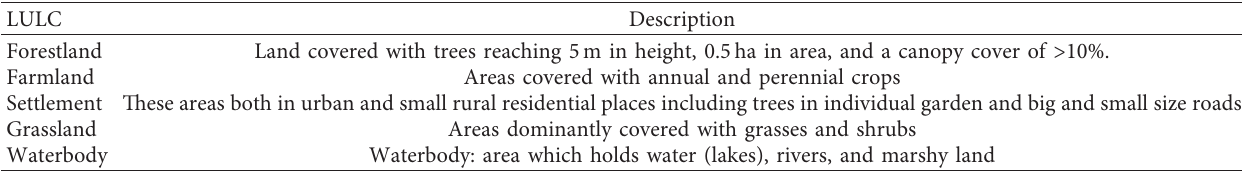
Table 2: Description of the LULC classification system.